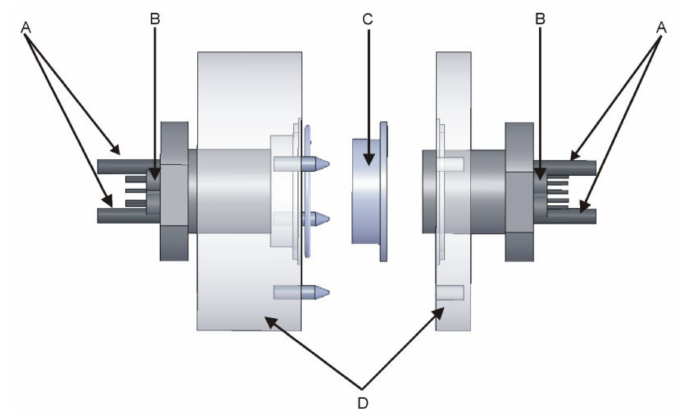
Figure 1. Schematic model of apparatus included. ( A ) solution inlet and outlet tubes, ( B ) ion-selective and reference electrodes, ( C ) Costar Snapwell insert with epithelial cell monolayer, and ( D ) asymmetric body. The diameter of the body is 4 cm. Distance between the cell layer and ion-selective electrodes is less than 30 µ m. The inner diameter of the Costar Snapwell insert is 12 mm.